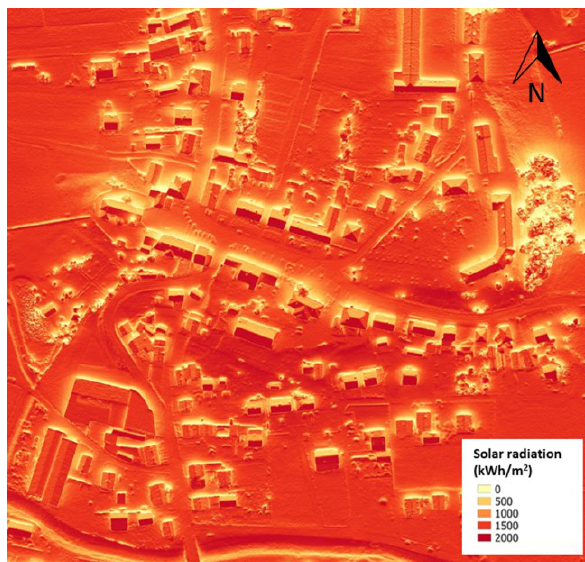
Figure 7. Solar potential in the test area for the whole year The solar potential of the pilot area at the annual level is presented on Figure 7. At first sight, this figure is very similar to the solar potential of the observed area in July (Figure 5.).